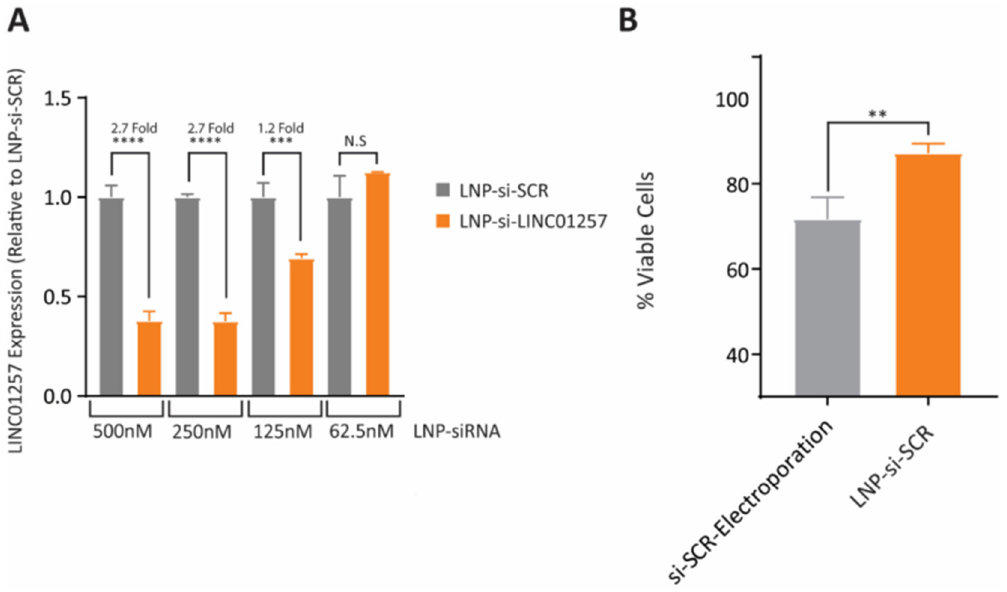
Figure 6. si-LINC01257 siRNA-loaded LNPs effectively target the expression of LINC01257 when tested in Kasumi-1 cells. ( A ) RT-qPCR profile of LINC01257 expression at varying concentrations of LNP-si-SCR after 72 h of treatment. ( B ) Viability of Kasumi-1 cells following either 72 h treatment with LNP-si-SCR or electroporation with si-SCR. **** = p < 0.0001, *** = p < 0.001, ** = p < 0.01 N.S = no significance, n = 3. Adapted from ref. [165], Pharmaceutics 2021.